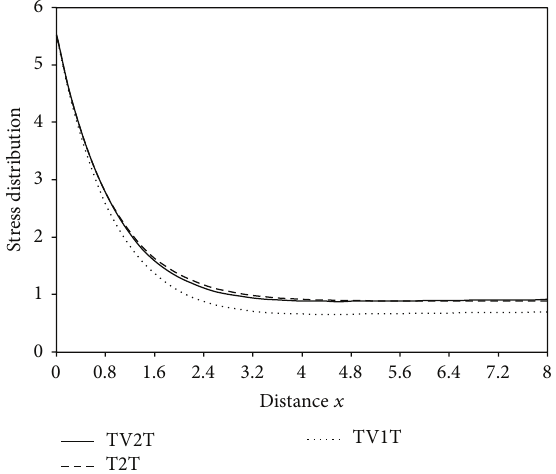
Figure 8: Dependence of conductive temperature on velocity V of heat source.